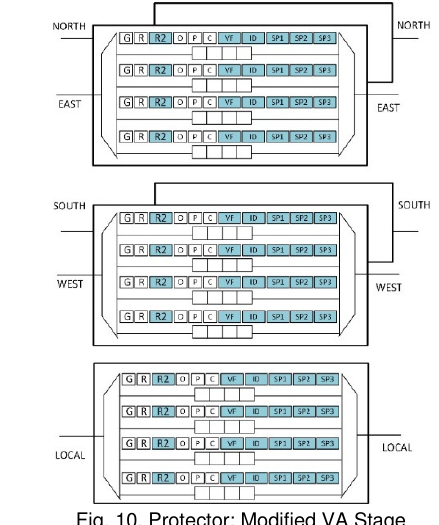
Fig. 10. Protector: Modified VA